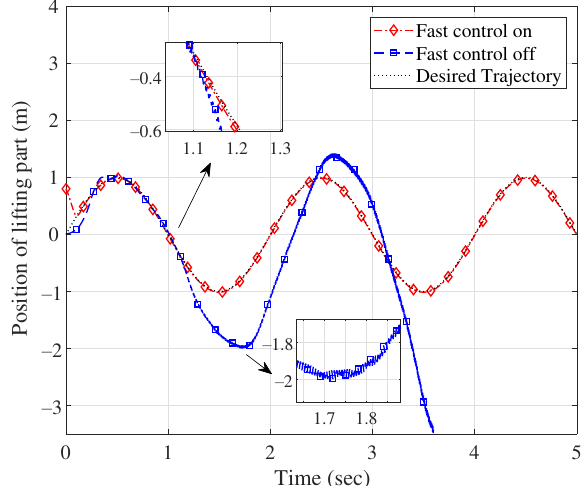
Figure 22. Position of lifting part (Group 4).